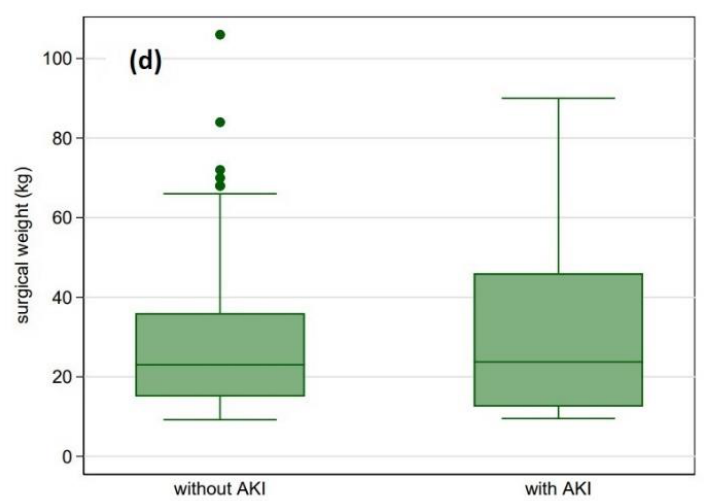
Figure 1. ( a – d ) Acute Kidney Injury association with surgical age and surgical weight. Both surgical age and weight were associated with AKI only with values below medians. ( a ) Surgical age below median vs. AKI ( p < 0.001), ( b ) Surgical age (all values) vs. AKI ( p = 0.7), ( c ) Surgical weight below median vs. AKI ( p < 0.001), ( d ) Surgical weight (all values) vs. AKI ( p = 0.74). Table 4. Multivariate logistic Clinical outcomes according to AKI status are shown in Table 5. Patients in the AKI group experienced longer DMV (both total and postoperative), longer PICU (total and postoperative) and hospital LOS, with all differences being significant. Table 5. Clinical outcomes according to AKI.